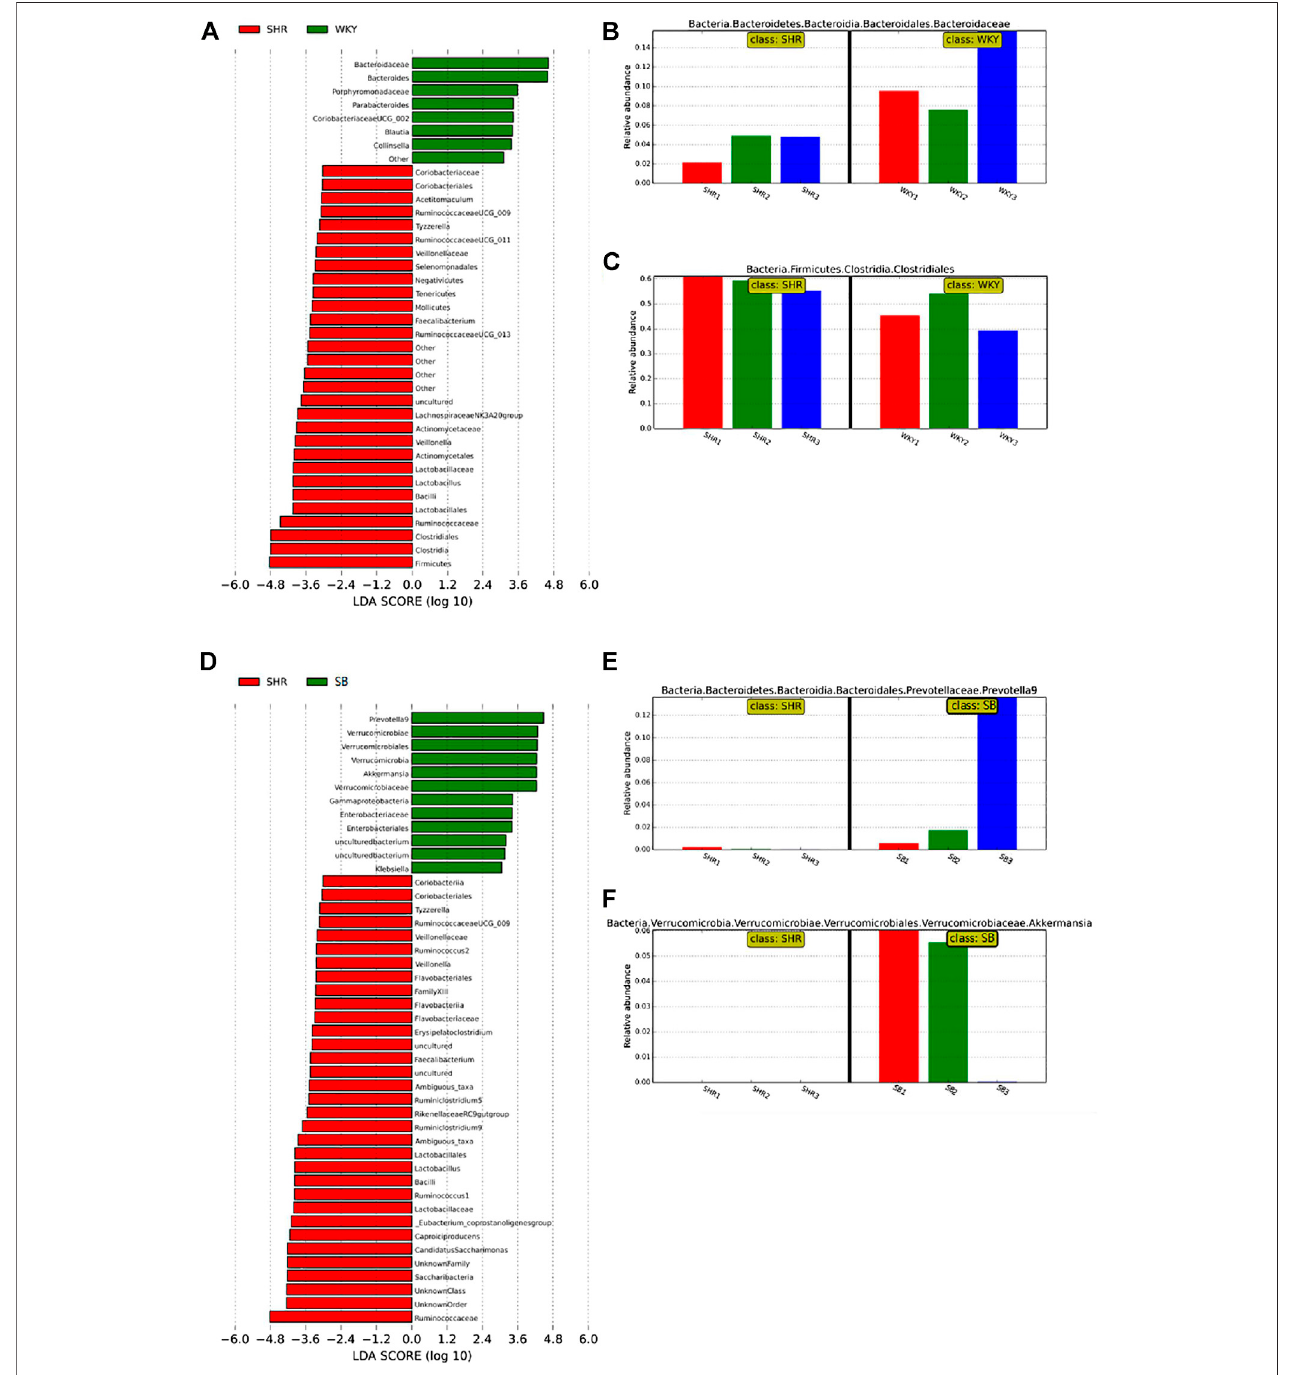
FIGURE 4 | (A – C) Bar diagram of LEfSe on the gut microbiome between the WKY and SHR groups. (D – F) Bar diagram of LEfSe on the gut microbiome between the SB and SHR groups. (G – I) Bar diagram of LEfSe on the gut microbiome between the SJ and SHR groups. (J – L) Bar diagram of LEfSe on the gut microbiome between the SB + SJ and SHR groups. (M,N) Bar diagram of LEfSe on the gut microbiome between the CAP and SHR groups.